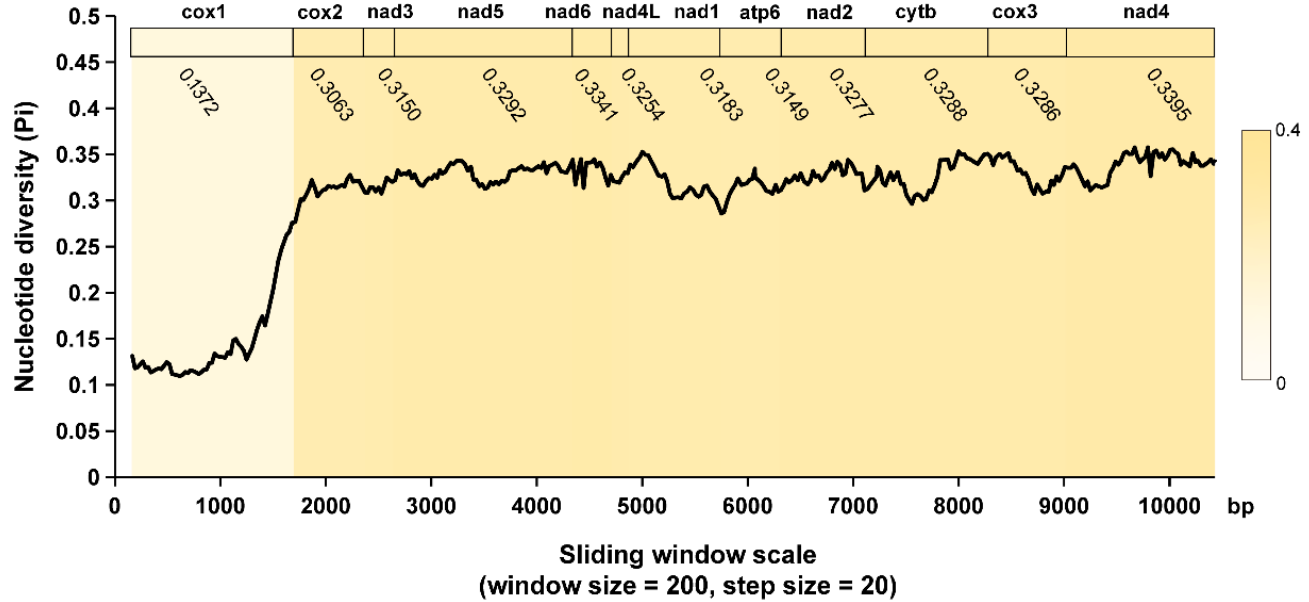
Figure 6. Sliding window analysis of the concatenated alignments of PCGs. The black line represents the value of the nucleotide diversity and are calculated using the parameters: window size = 200 bp and step size = 20 bp. Gene names, boundaries, and average nucleotide diversity values are indicated above the graph. Colors from yellow (high diversity) to white (low diversity) indicate the different nucleotide diversities.